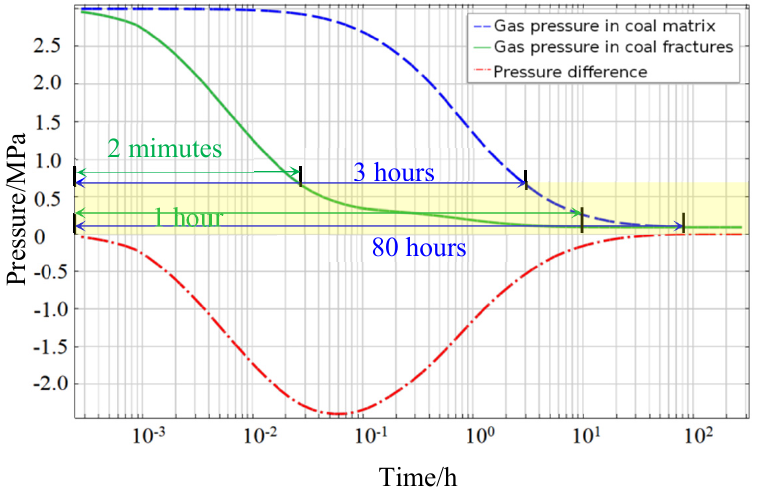
Figure 11. Gas pressure changes for Anderson coal under drainage condition.